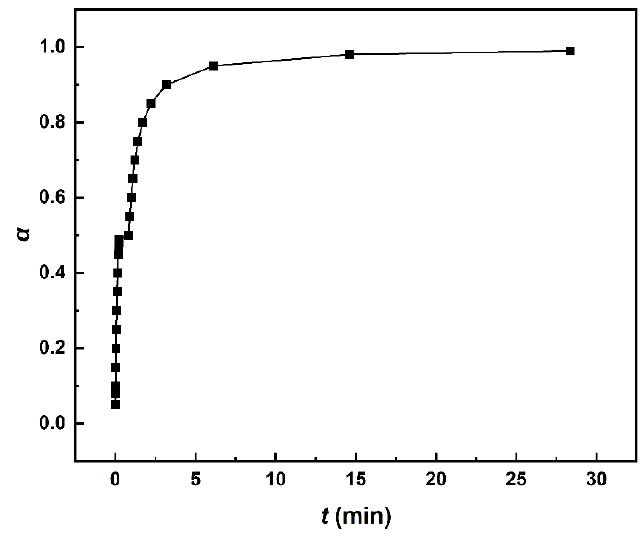
Figure 10. The curve of α - t under optimal curing conditions.